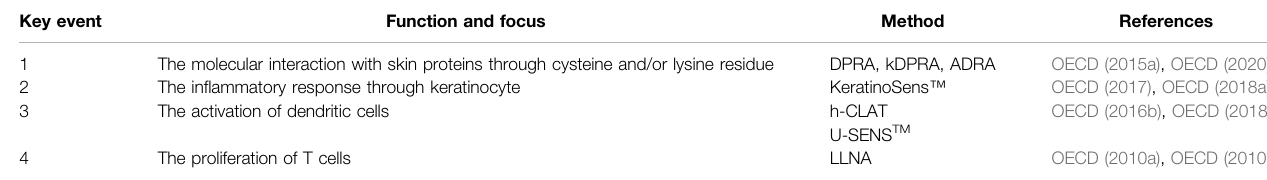
TABLE 1 | Animal and non-animal tests to evaluate the potential of the human skin sensitization of new substance depending on key events in AOP (OECD,